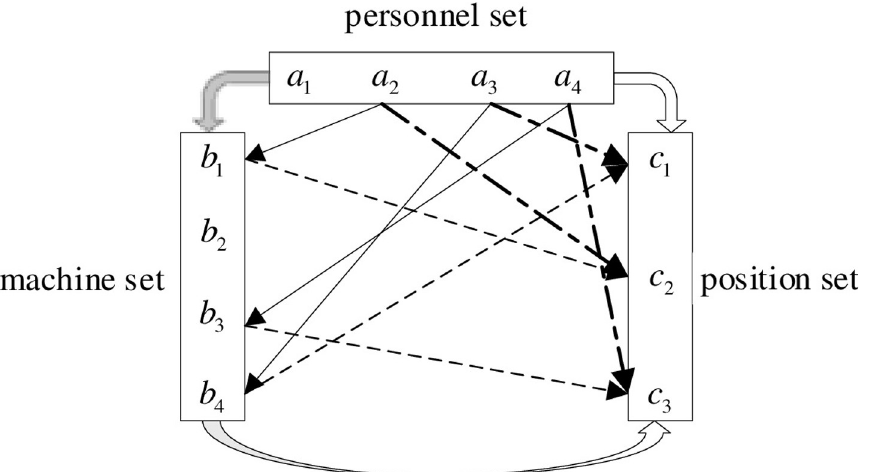
Fig 1. Three-side matching model of personnel–robot